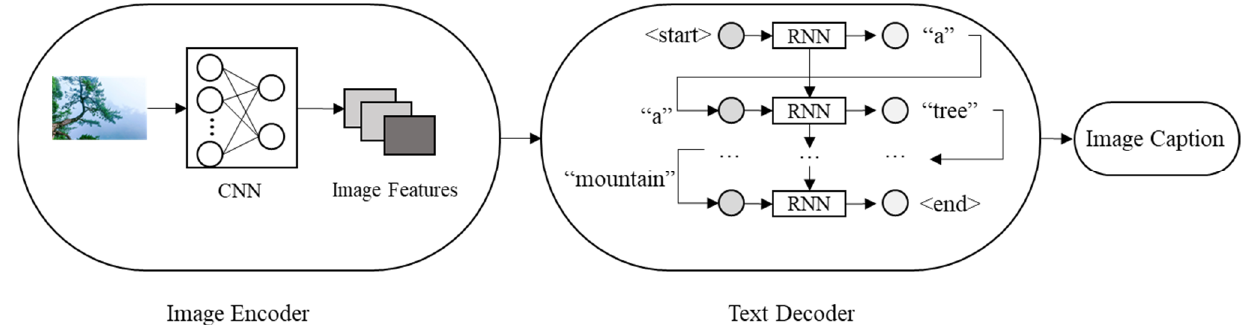
Figure 2. Encoder-decoder framework with CNN–RNN.